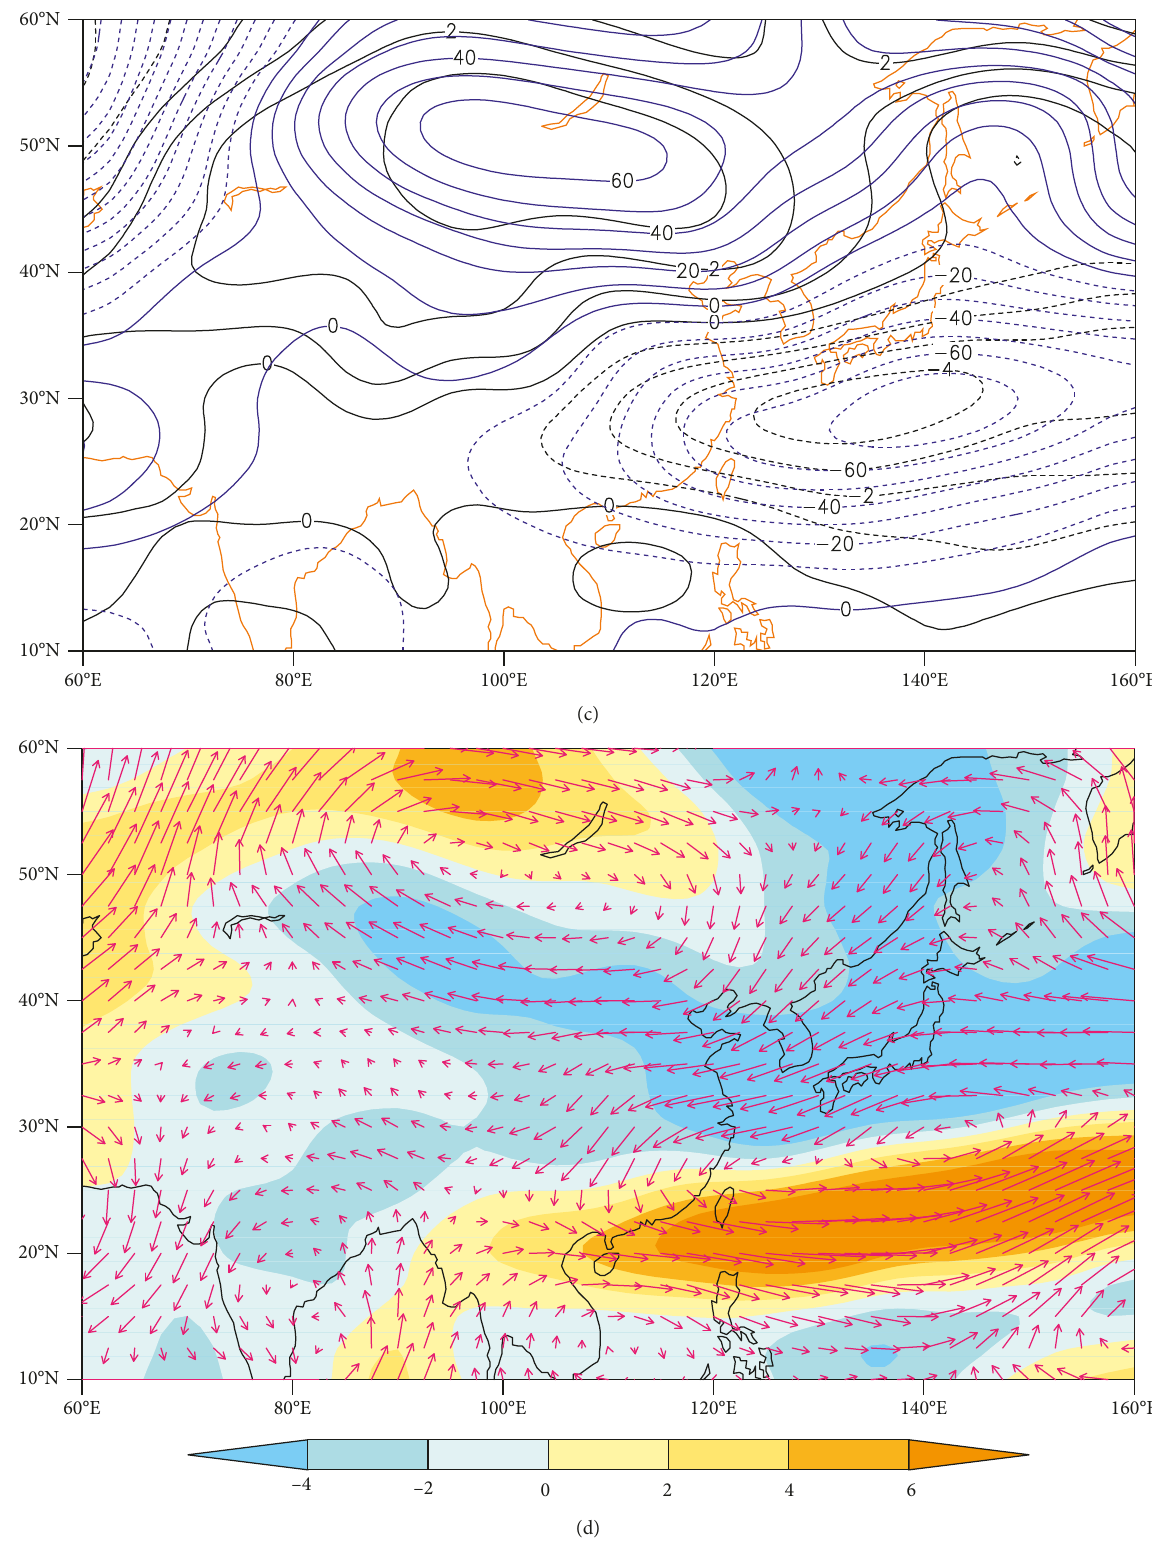
Figure 5: Spatial patterns of anomalous fields at 925 hPa from 1 to 9 December 2013. (a) Geopotential height and temperature. The blue contours are geopotential height (gpm), and the black contours are temperature ( ° C). (b) Wind speed and wind direction. The red arrows represent the wind direction ( ° ), and the shading represents the wind speed (m respectively, but for anomalous fields at